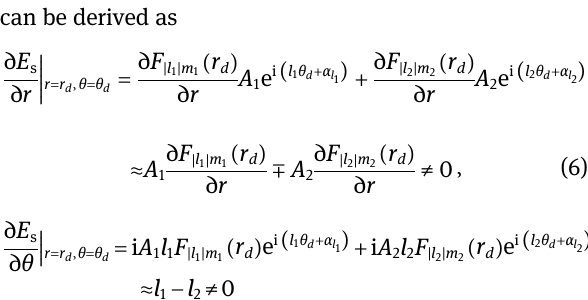
fi eld consists of 0 . 8 V . 2 V − 11 . Arrows painted four 31 and 0 colors surround those areas around the destructive